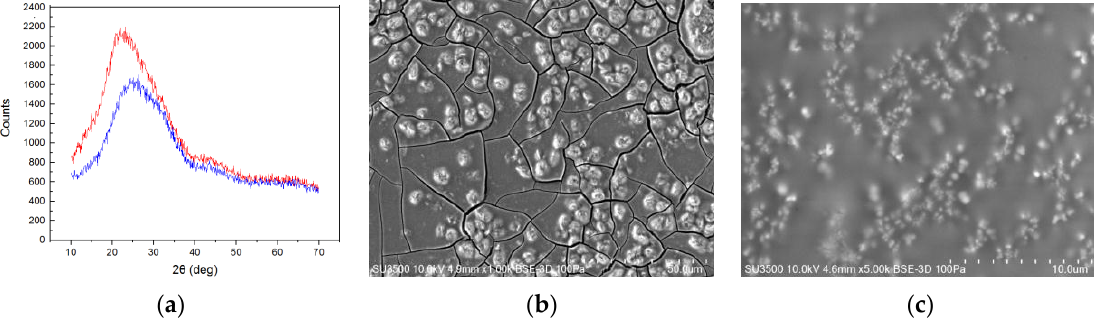
Figure 5. ( a ) XRD patterns of poly(Ti–O–Si precursor) ( – ) and poly(Ti–O–Si precursor-co-OPPEA) hybrid films ( – ). SEM images of ( b ) poly(Ti–O–Si precursor) and ( c ) poly(Ti–O–Si precursor-co-OPPEA) hybrid films